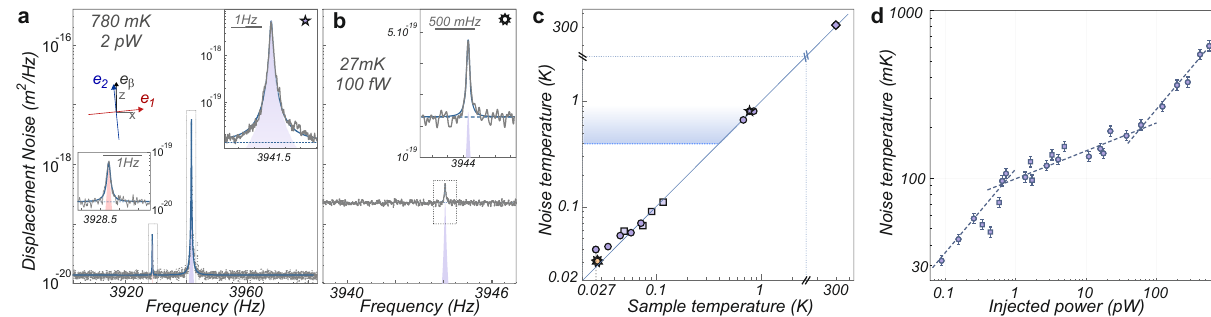
Fig. 3 Noise thermometry. a Calibrated thermal noise spectrum obtained on nanowire A for an experiment temperature of 780 mK. The eigenmode orientations and effective mass are unchanged, while the quality factor is increased to ≈ 80,000. b Similar measurement obtained for an injected power of 100 fW at 27 mK. c Vibration noise temperature, T eff as a function of the sample temperature. Different measurements are shown, with suspensions (star/ squares) and without while stopping (circles) the mixture injection, using optical powers in the 100 – 300 fW range. The lowest noise temperatures obtained are around 32 ± 2 mK, for a sample temperature of 27 mK and a base temperature of 20 mK. The shaded area indicates the noise temperatures measured in absence of suspension. d Dependence of the nanowire noise temperature T eff measured for increasing injected optical powers while maintaining the cryostat at its minimal temperature. The dashed lines are indicative power laws of 1/2, 1/5, and 1/2, to illustrate the different regimes of sublinear heating rates the conversion coef fi cient η = 3.98 × 10 8 V/(cts/s), which depends